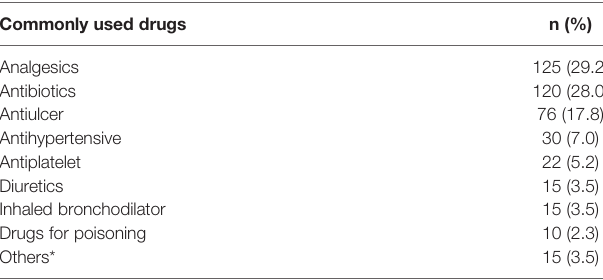
TABLE 3 | Commonly prescribed classes of drugs for patients admitted to the emergency department of HFSUH, Harar, Ethiopia, 2018 (n =